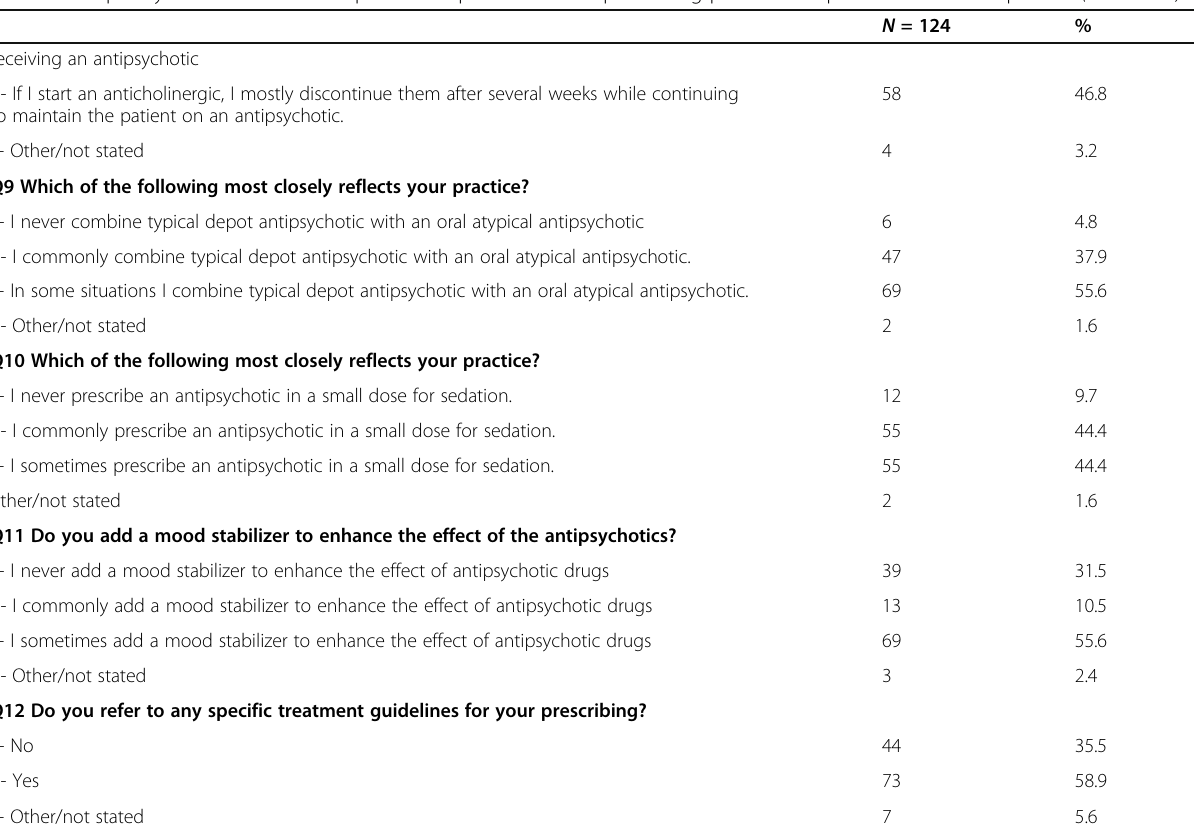
Table 2 Frequency of distribution of responses to questions about prescribing practices for patients with schizophrenia